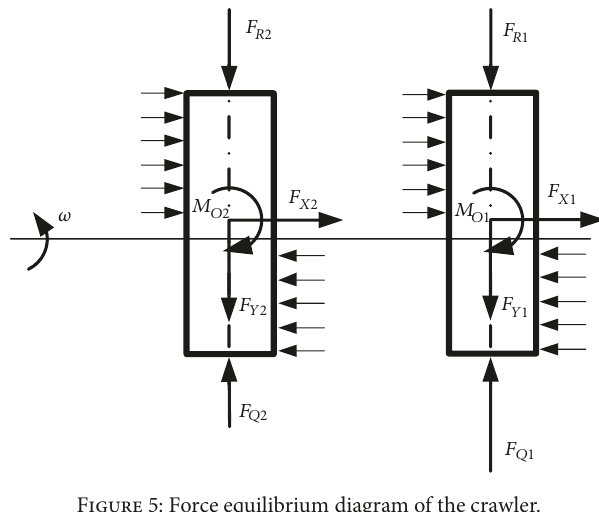
Figure 5: Force equilibrium diagram of the